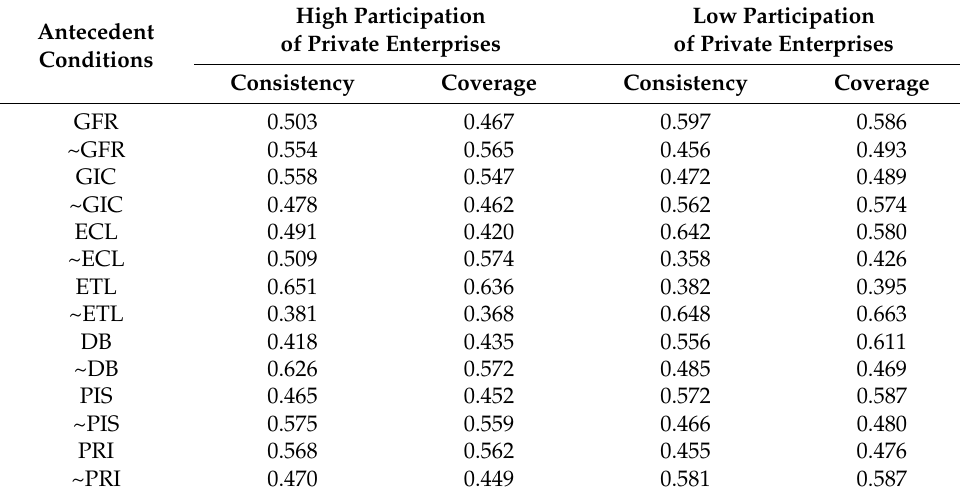
Table 3. The necessity test of a single condition in the QCA method.